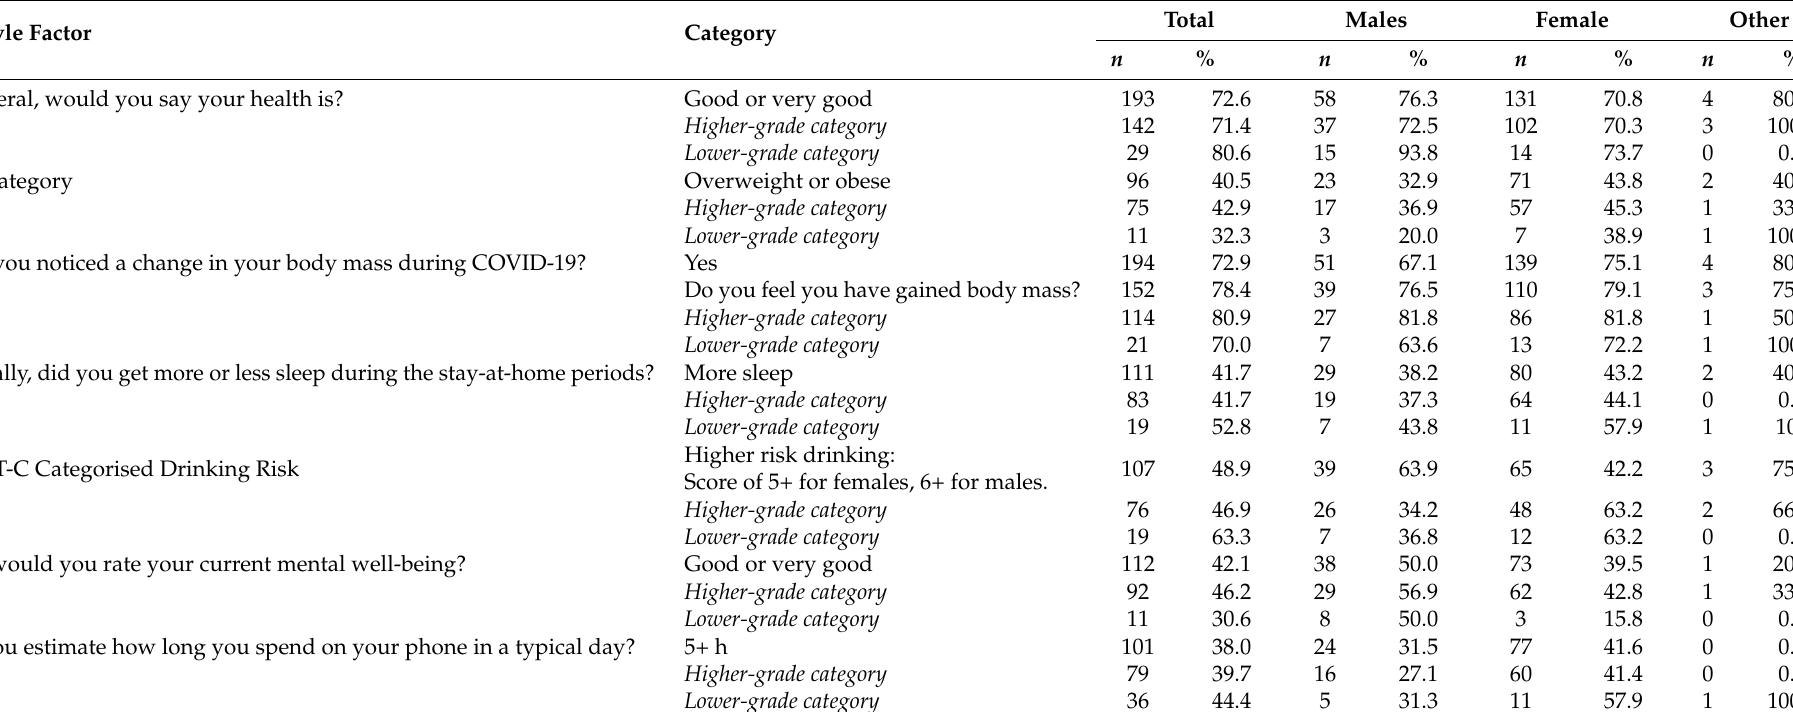
Table 4. Participants self-reported health and lifestyle variables stratified by gender and by dichotomized grade